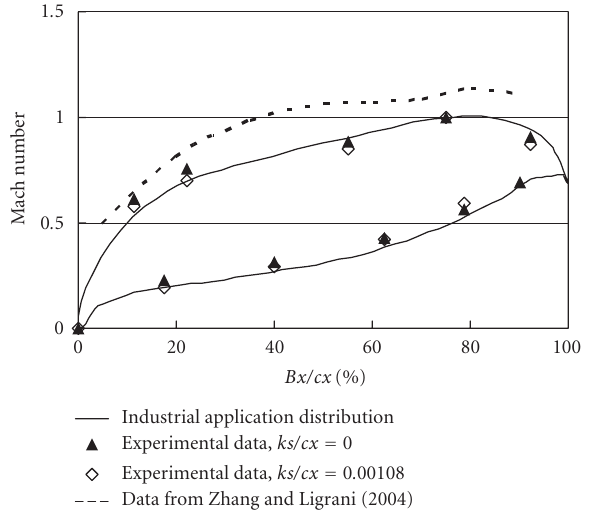
Figure 3: Mach number distributions along the cambered test air- foil.